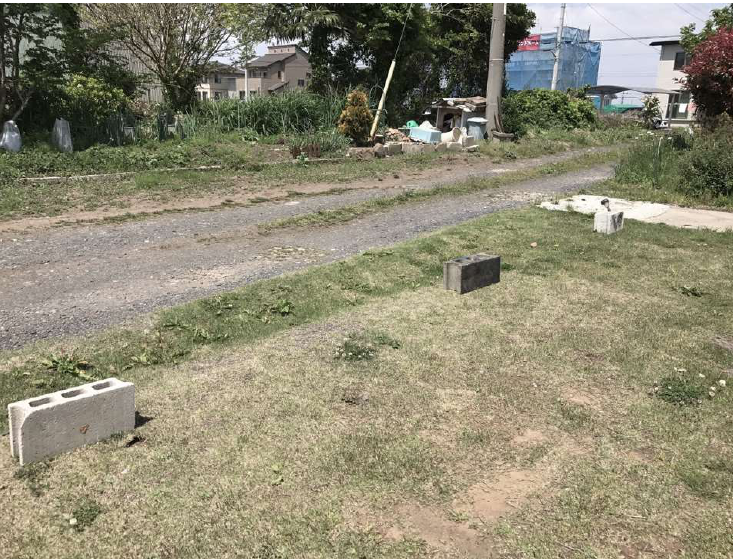
Figure 5. Some concrete blocks in front of the apartment where I lived.